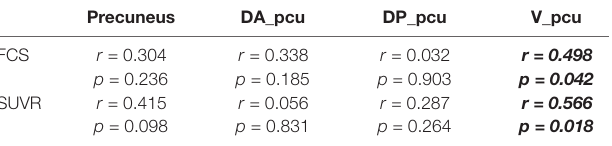
TABLE 2 | Associations of MMSE with FCS and SUVR in AD